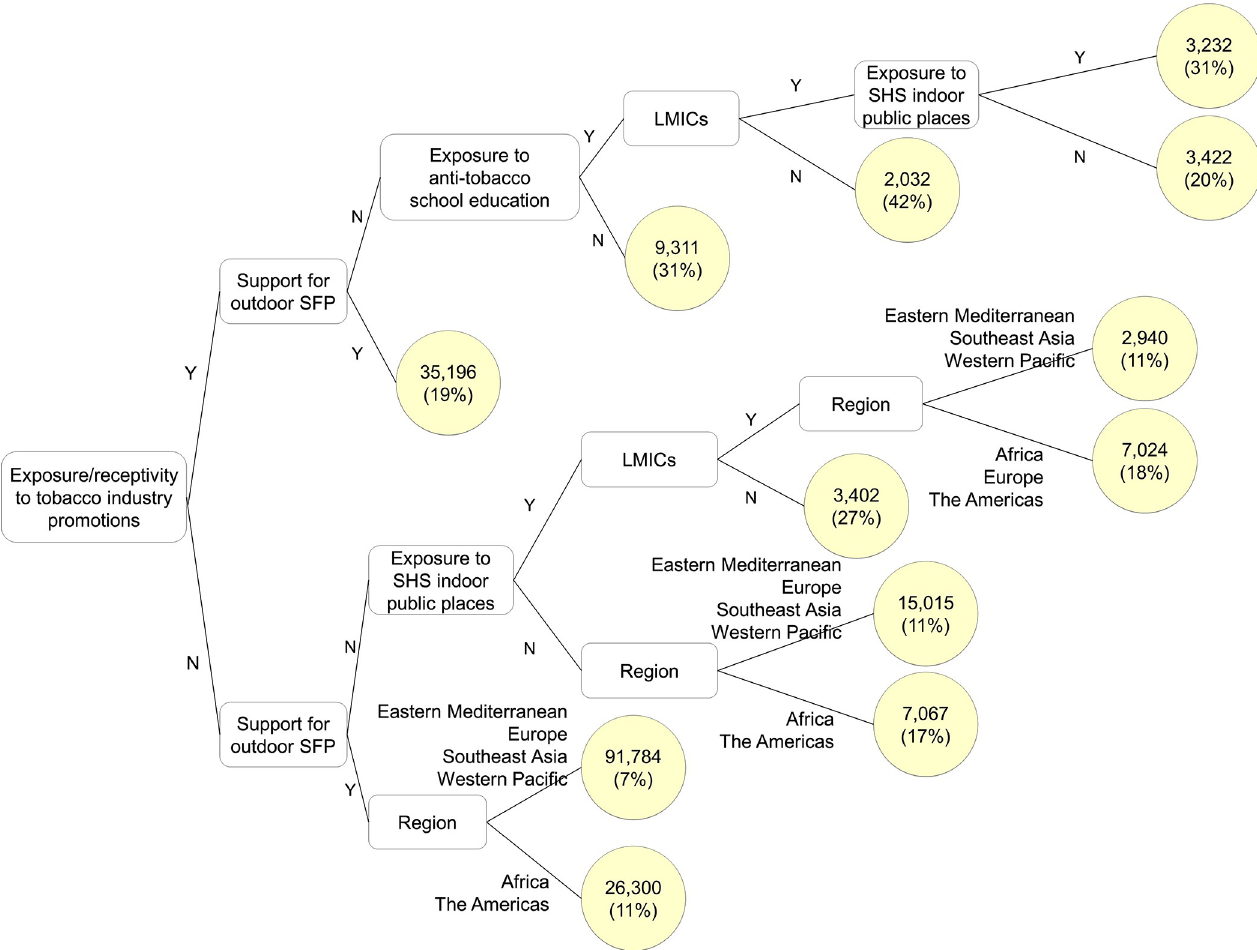
Fig 1. GUIDE regression tree model predicting susceptibility among tobacco-na ï ve adolescents aged 13–15 years from 97 countries in the Global Youth Tobacco Survey, 2013–2017. Unweighted counts of susceptibility (and weighted percentages) among subgroups are presented in yellow ovals. Y = yes, N = no, SFP = smoke-free air policy, SHS = secondhand smoke, LMICs = low-and middle-income countries. Region indicates WHO